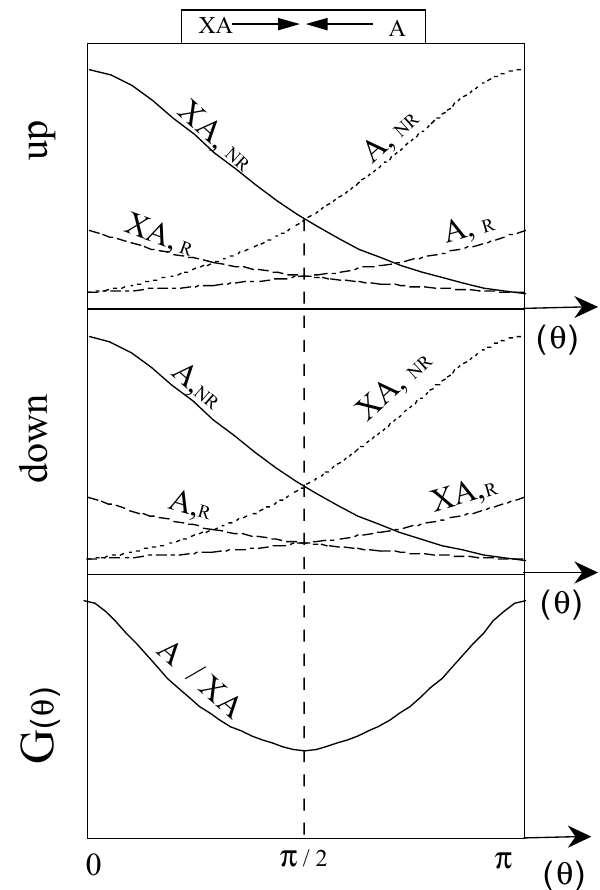
Fig. 4. Schematic diagram of the isotopic distributions of XA and A as a function of their scattering angles in the cross beam experi- ment shown in Fig. 3. Although drawn for heuristic purposes, XA and A resulting from reactive and non-reactive reactions cannot be experimentally distinguished. “Reactive” indicates that isotopes are exchanged in the course of the collision. The resulting overall dif- ferential cross section G(θ) = 1 / 2 { F T (θ) + F T (π − θ) } describing the reactions between A and XA is drawn in the lower part of the figure. G(θ) exhibits a marked enhancement around θ = π as com- pared to F(θ) (see Fig.